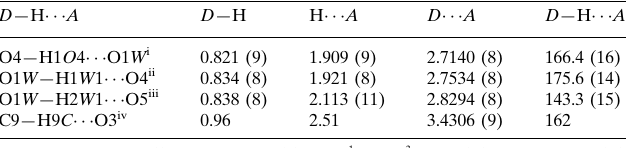
Data collection Bruker SMART APEXII CCD area-detector diffractometer Absorption correction: multi-scan ( SADABS ; Bruker, 2005) T min = 0.947, T max = 0.971 Refinement